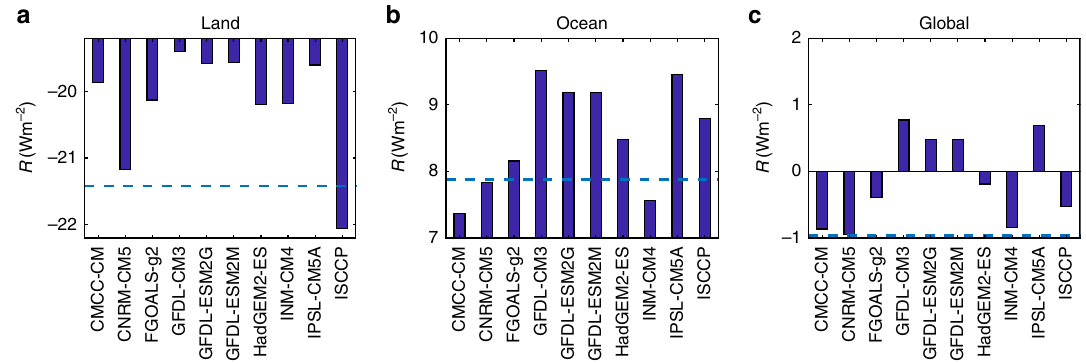
Fig. 4 Reference irradiance. Top-of-the-atmosphere reference irradiance over a land, b ocean, and c whole Earth calculated using the mean cloud coverage ( μ ) from reanalysis data and the departure of mean cloud coverage ( f DCC ) from each data source. The dash lines show the top-of-the-atmosphere reference irradiance from reanalysis data. Note that the reanalysis is not designed to conserve the energy balance 48, 49 ; therefore, the deviations from the standard reanalysis, rather than their absolute values, are more meaningful to quantify the radiative impacts of the DCC